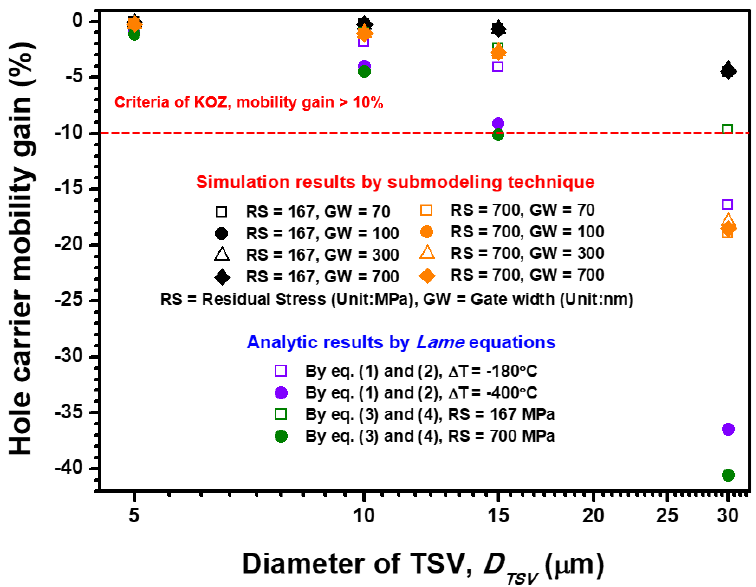
Figure 8. Comprehensive stress-induced impact on Si pMOSFET performance under different com- binations of TSV/device layout design and TSV residual stress magnitude. The hole carrier mobility gain is estimated by the simulated stress components integrated with the piezoresistive behavior of Si.